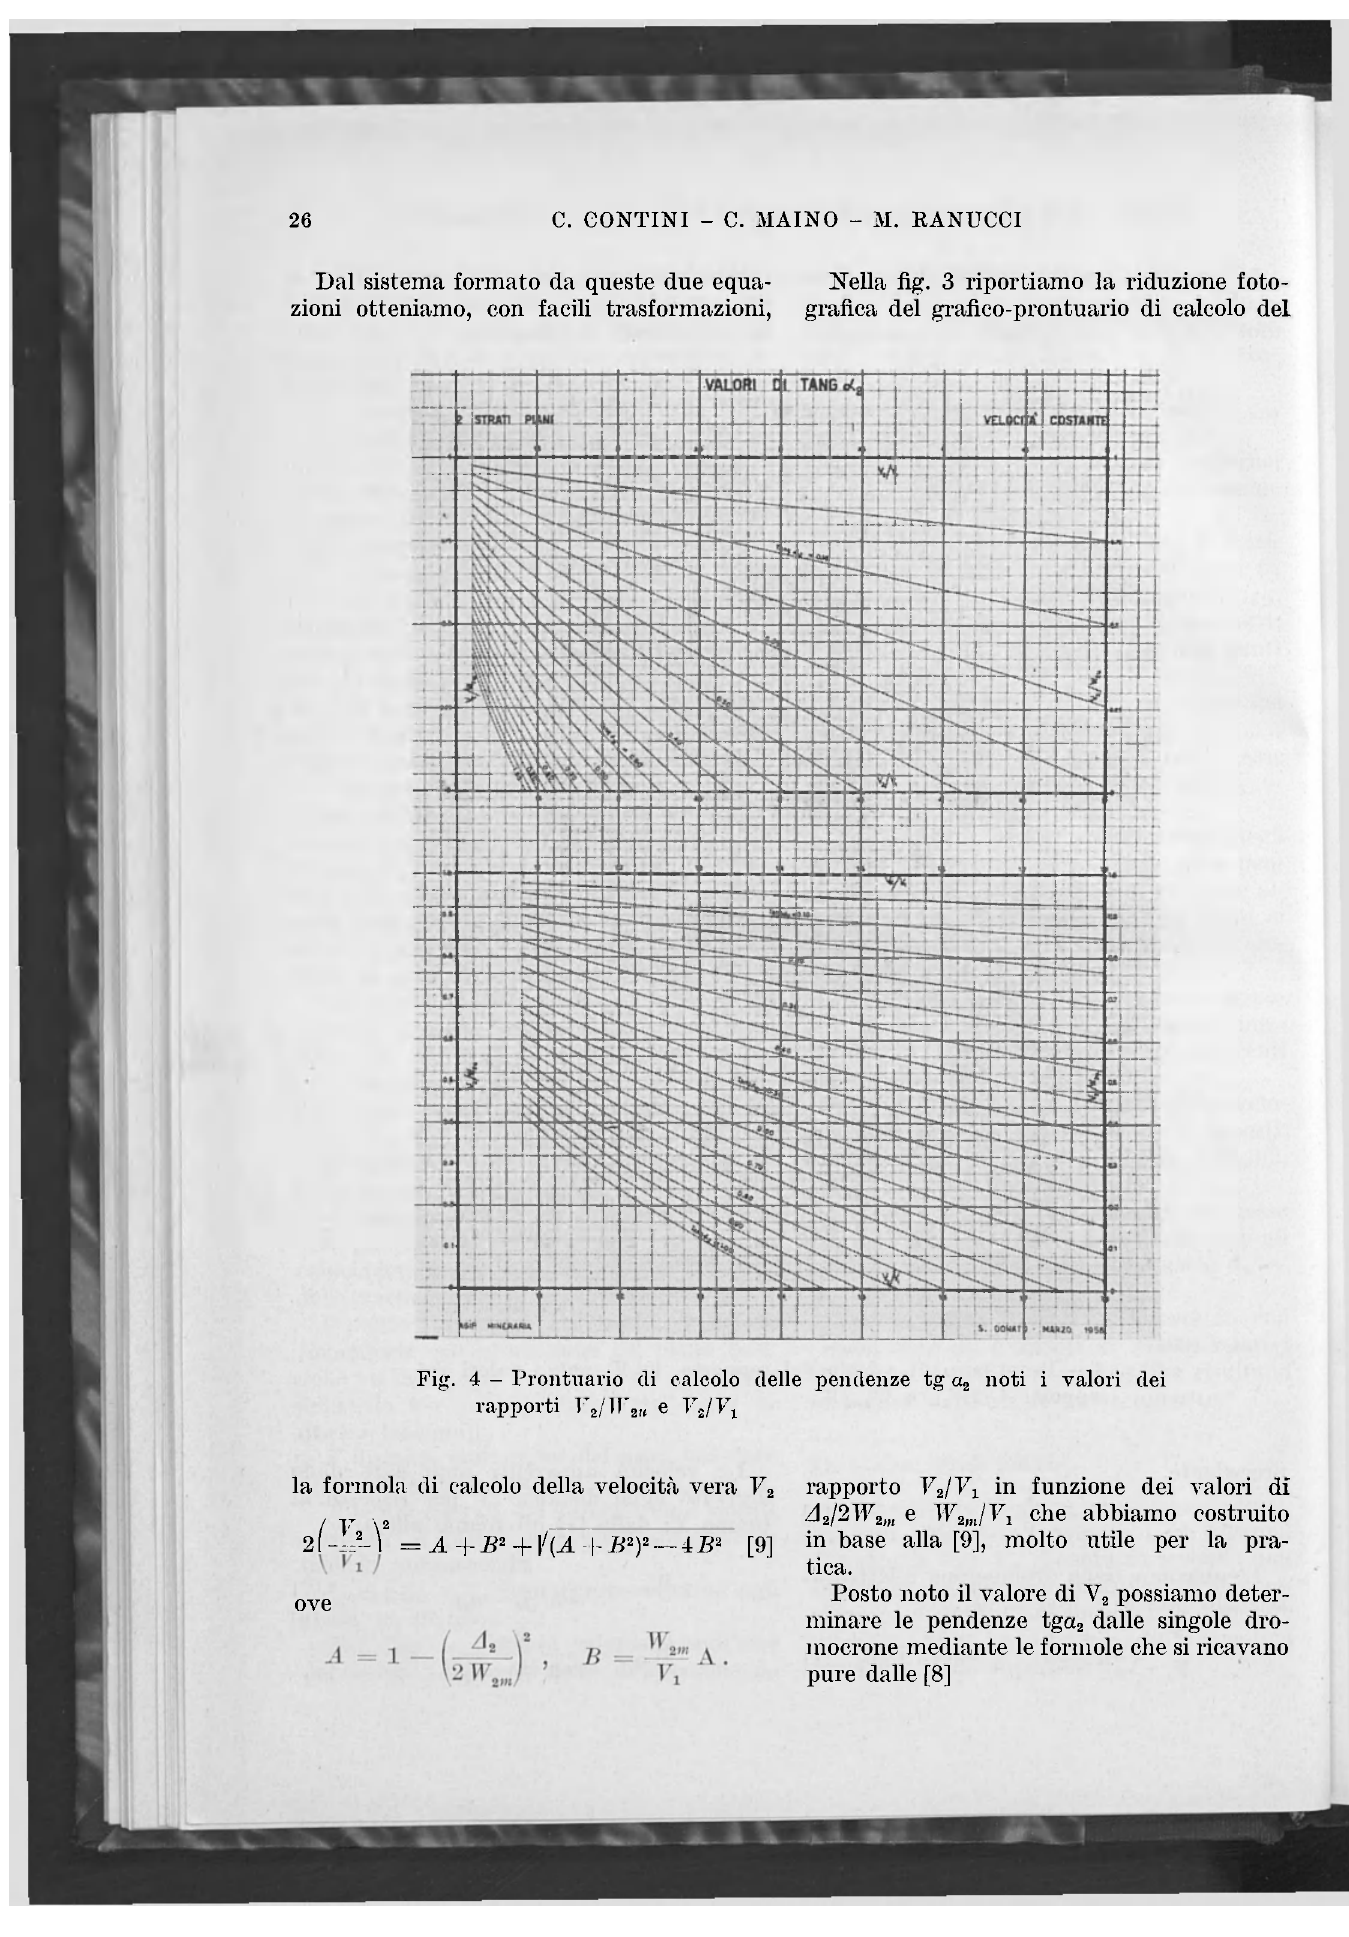
Fig. 4 - Prontuario di calcolo delle pendenze tg a 2 noti i valori dei rapporti VJW 21( e VJV